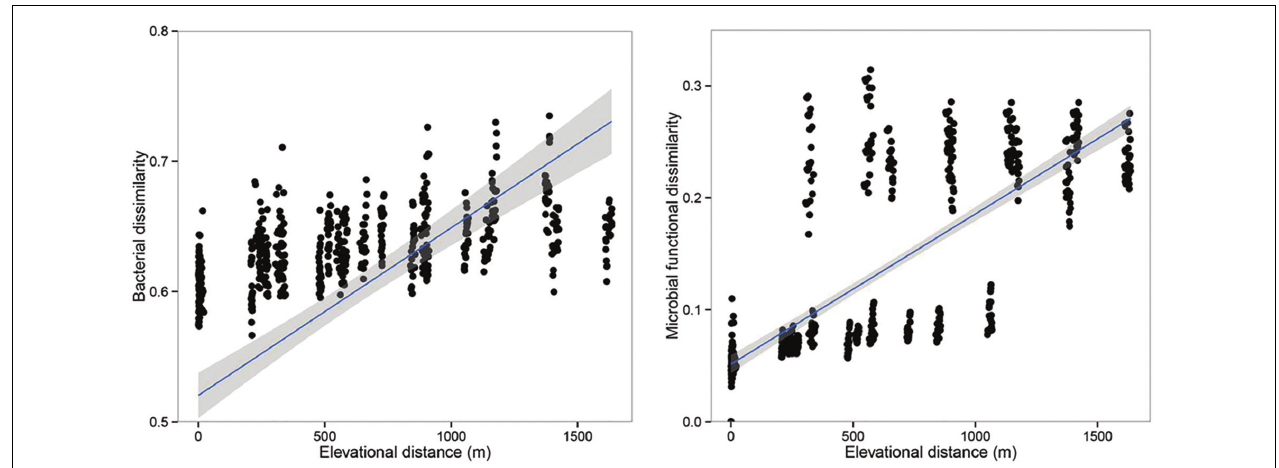
FIGURE 5 | The relationships between the community dissimilarity (bacterial communities and microbial functional genes) and elevational change. Both the bacterial communities and microbial functional genes showed significant elevational distance-decay patterns ( r = 0.409, p < 0.001; r = 0.708, p < 0.001).